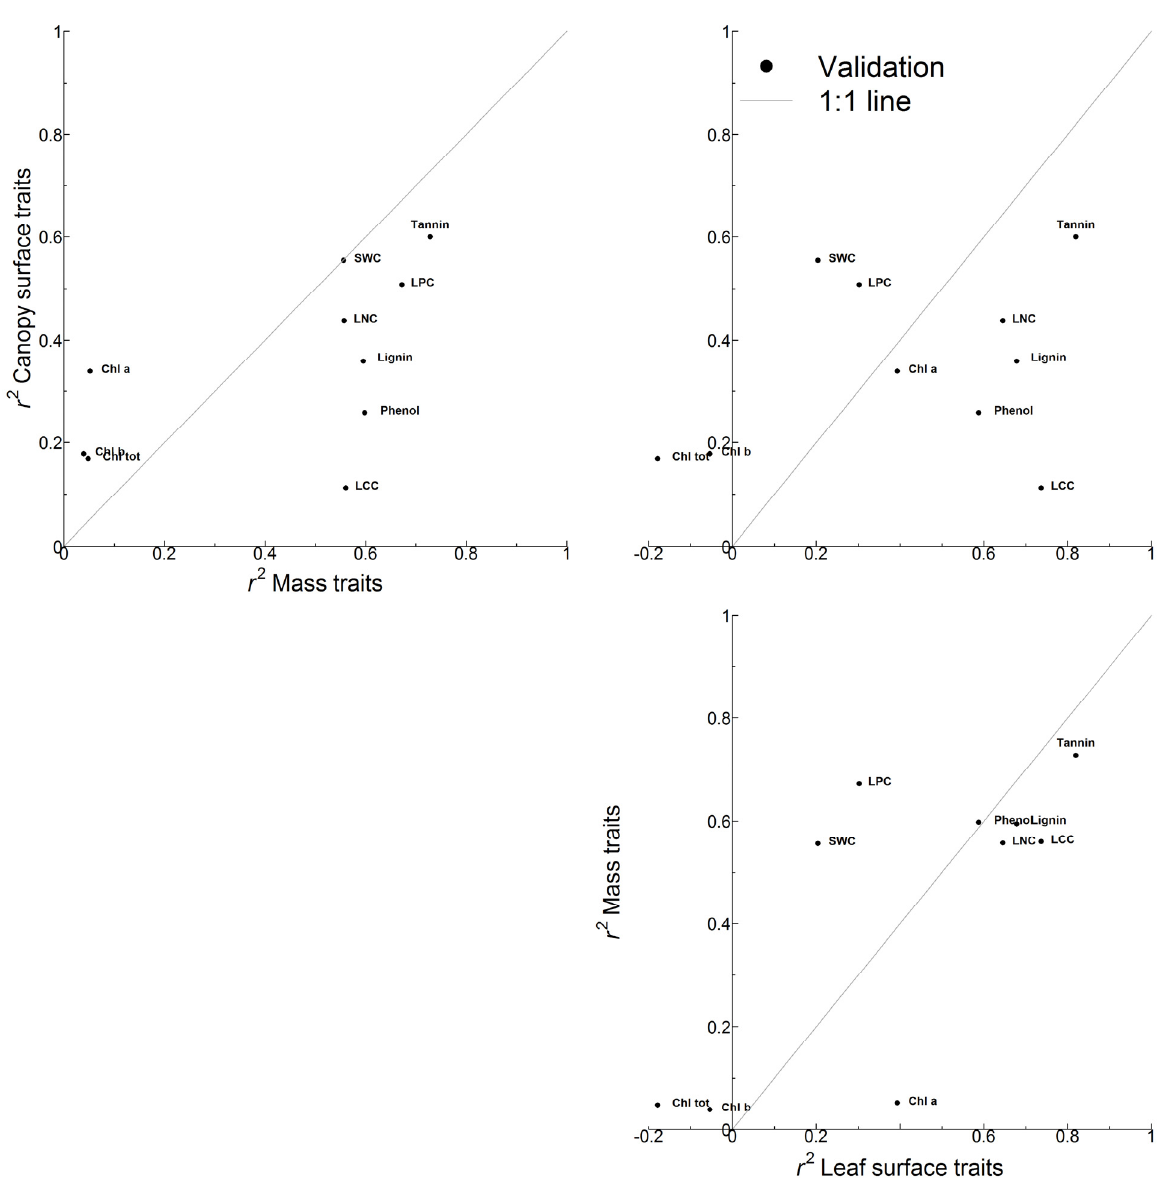
Figure 4. Scatterplot of the coefficient of determination ( r 2 ) for the validation of all PLSR models, plotted for mass based ~ canopy surface traits, leaf surface ~ canopy surface traits and leaf surface ~ mass based